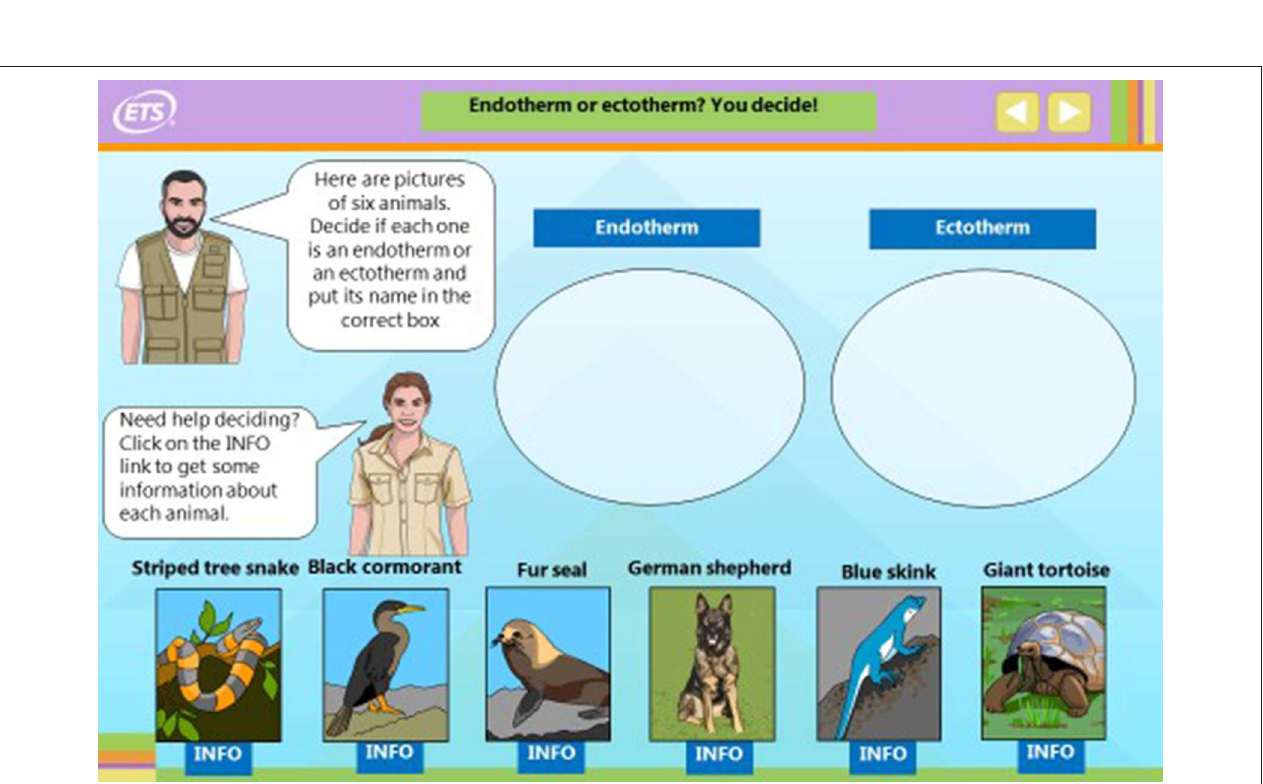
FIGURE 6 | Example 2 of scaffolding activities to learn construct-relevant vocabulary.